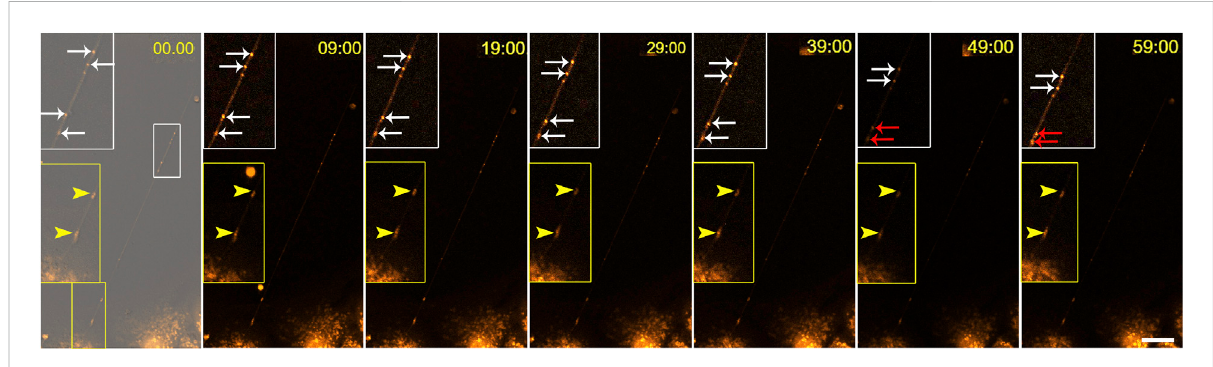
FIGURE 9 Traf fi c of mitochondria in TNTs. NPU cells were labelled with MitoTracker and live-cell imaging was performed for 1 h at 10-min intervals. The full sequences is available in Supplementary Videos S3. Inside the TNTs, mitochondria with different dynamics were observed: mitochondria that were moving (white arrows) and mitochondria that were not moving (yellow arrows). Red arrows denote mitochondria approaching each other. Scale bar: 20 μ